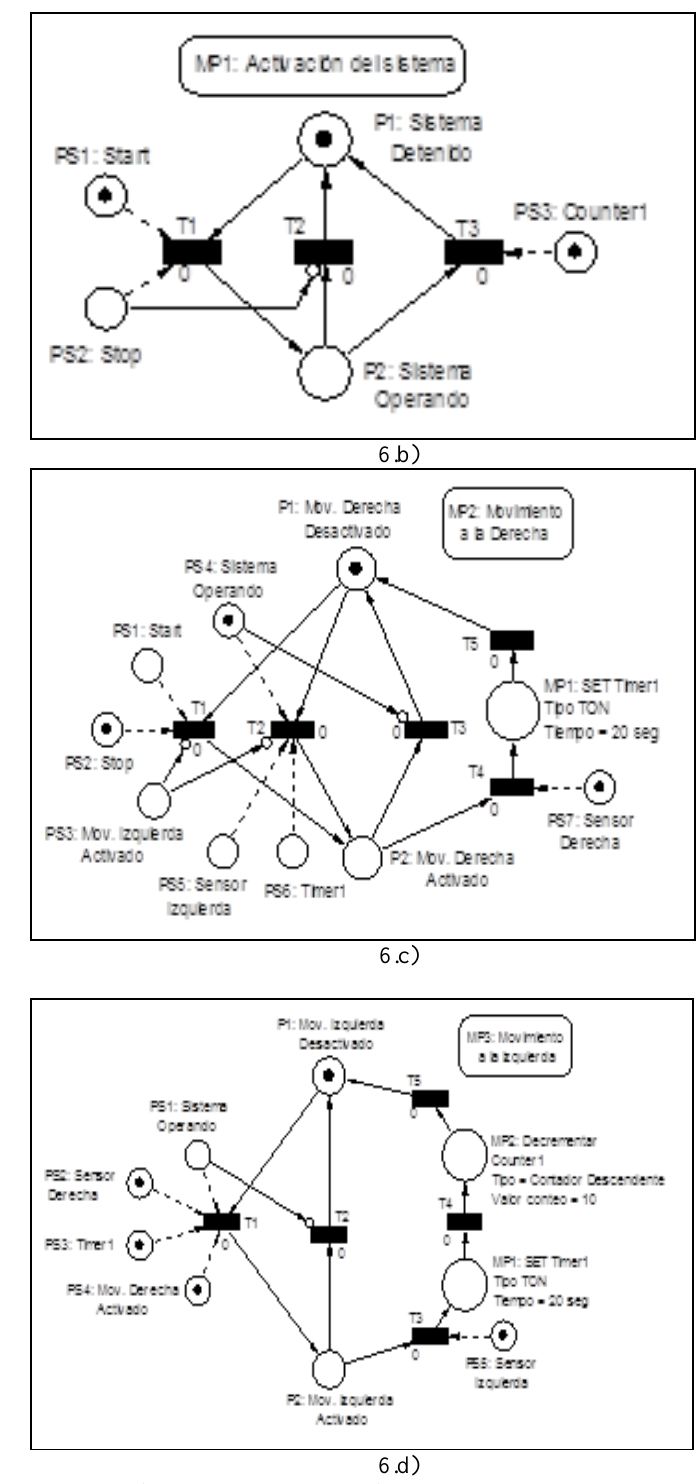
Figura 6: a) Programa principal, b) subred activación del sistema, c) subred movimiento a la derecha, d) subred movimiento a